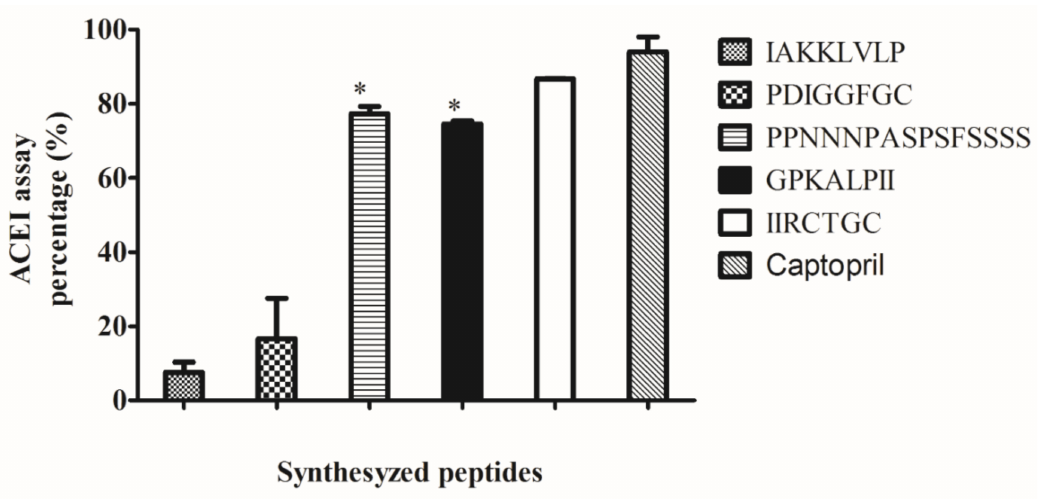
Figure 2. The ACE inhibitory ability of selected peptides from P-SPI. Bars represent the means of three replicates ( n = 3) ± SD, * p <